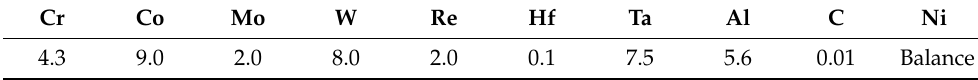
Table 1. Chemical composition of the DD6 single-crystal superalloy.